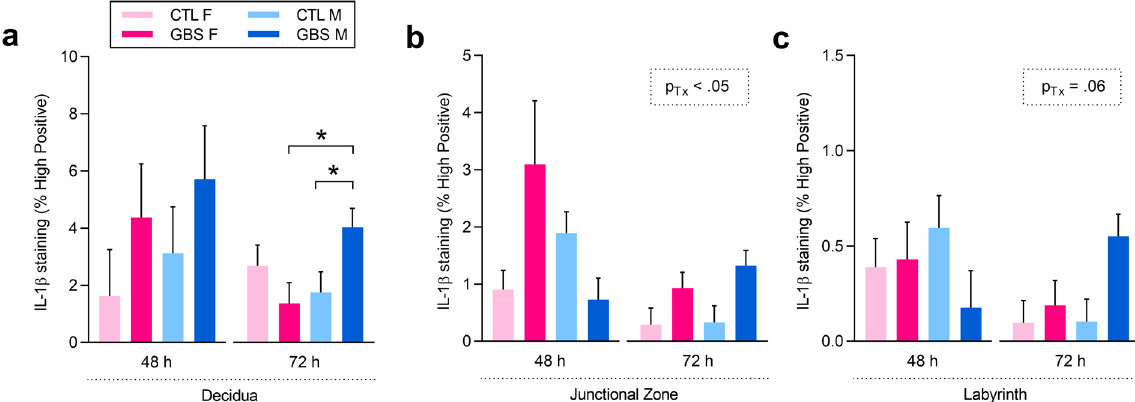
Figure 5. In-situ immunohistochemical analysis revealed sex- and placental compartment-specific increases of IL-1 β following GBS-induced acute chorioamnionitis. ( a – c ) Percentage (%) of high positive staining for IL-1 β in the decidua ( a ), junctional zone ( b ) and labyrinth ( c ) placental compartments at 48 and 72 h post-injection. Analyses were done by linear mixed model and significant results are shown in the dashed box. Sidak’s multiple comparisons were used when the interaction between sex and treatment was significant. * P < 0.05. Bars represent mean ± SEM. Number (n) of placentas: n = 3 [48 h] and n = 6 [72 h] per sex in the GBS group, and n = 5 [48 h] and n = 5 [72 h] per sex in the CTL group. One male and one female placentas were used per litter.